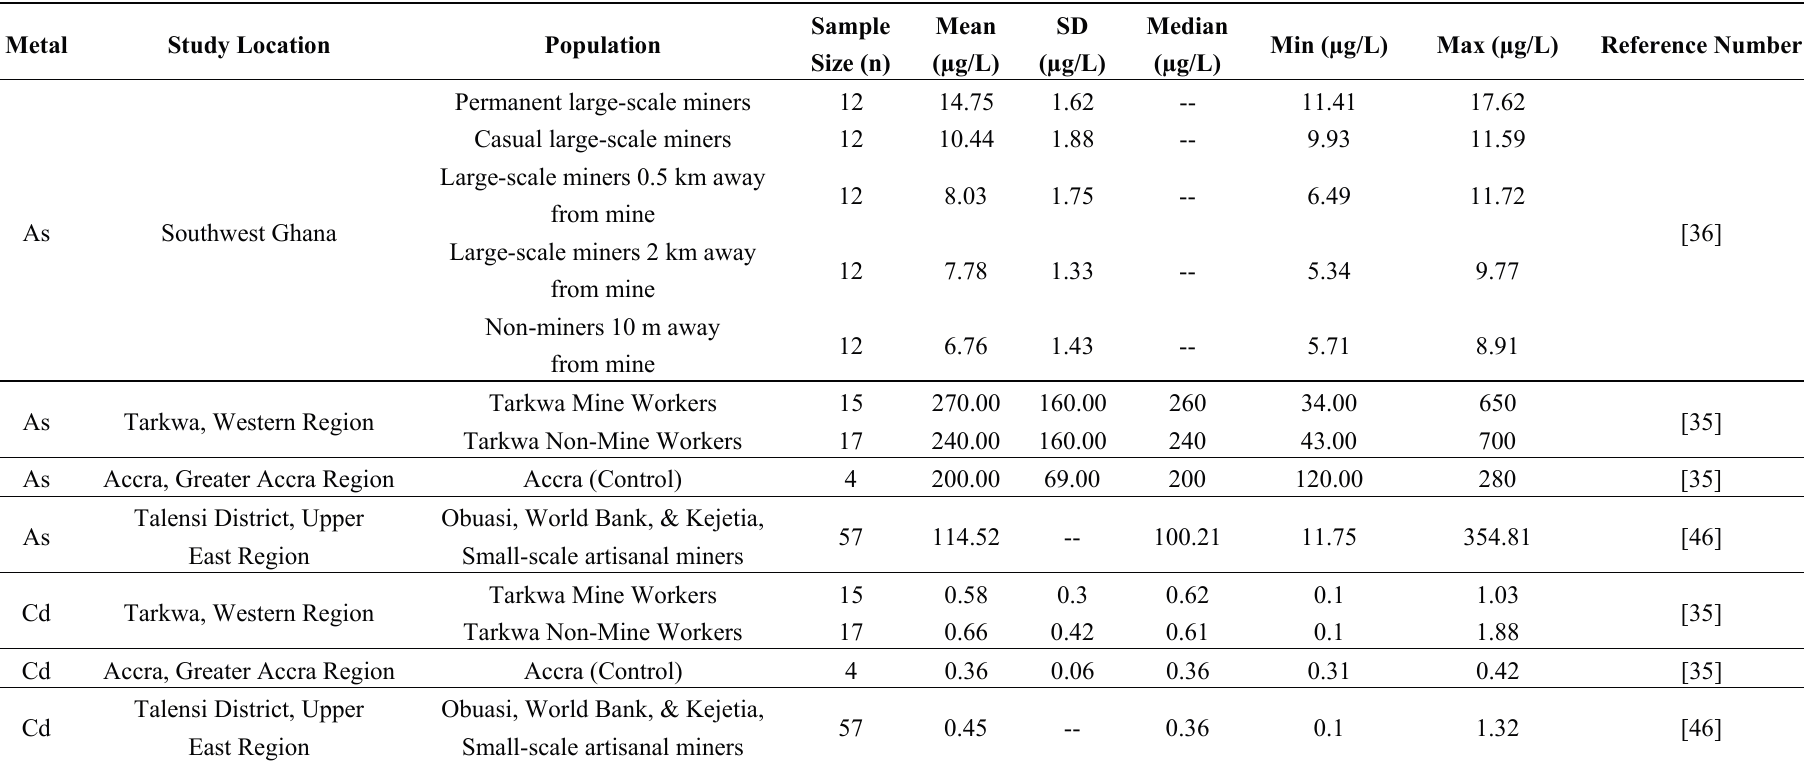
Table 1. Arsenic (As) and cadmium (Cd) in human urine from ASGM miners and non-miners from across